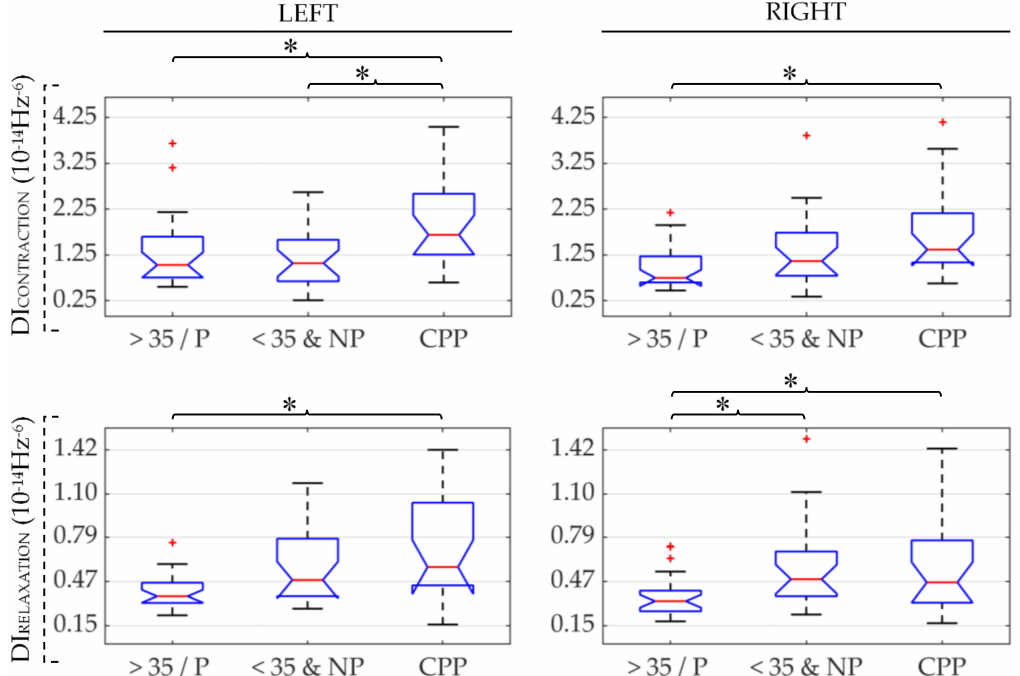
Figure 5. Box-whisker plots of Dimitrov index (DI) values of the left and right PFM (left and right subfigures, respectively) in patients (CPP), healthy women over 35 and/or parous (>35/P) and healthy women under 35 and nulliparous (<35&NP) during PFM contraction and relaxation (first and second rows, respectively). (*): significant difference between groups under the ends of the brace. Red (+): outlier within the group’s data